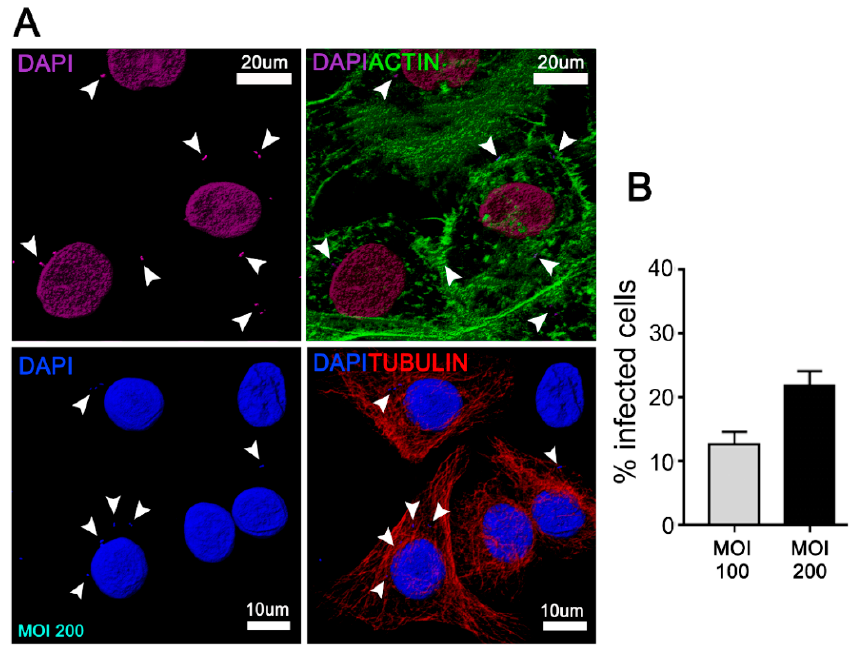
Figure 1. Junctional epithelium keratinocytes (JEKs)-invasion by Aggregatibacter actinomycetemcomitans ( Aa ). OKF6 / TERT-2 cells were incubated with A.a (serotype b) at MOI = 100 and 200 for 3 h at 37 ◦ C. After the corresponding washes, JEKs were fixed and subjected to confocal microscopy analysis for the quantification of infected cells. ( A ) Immunofluorescence staining using actin (upper panel in green) and tubulin (bottom panel in red) to delineate cell contour, as well as DAPI (purple, upper panel and blue, bottom panel) for visualization of cell nuclei and bacteria. White arrowheads indicate intracellular bacteria. ( B ) The graph shows the average of 15 images acquired by confocal microscopy using a 63 × objective in five independent experiments ( ≥ 1000 cells). Scale bar 10 and 20 µm.